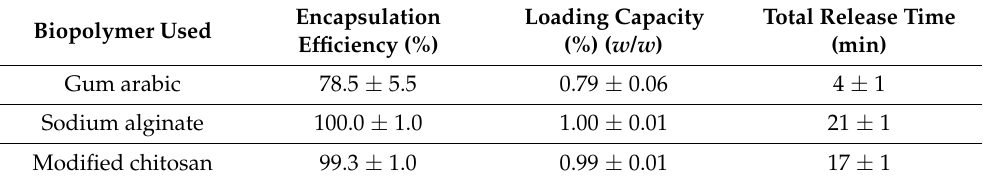
Table 2. Encapsulation efficiency, loading capacity and time parameters of the EGCG release. Biopolymer